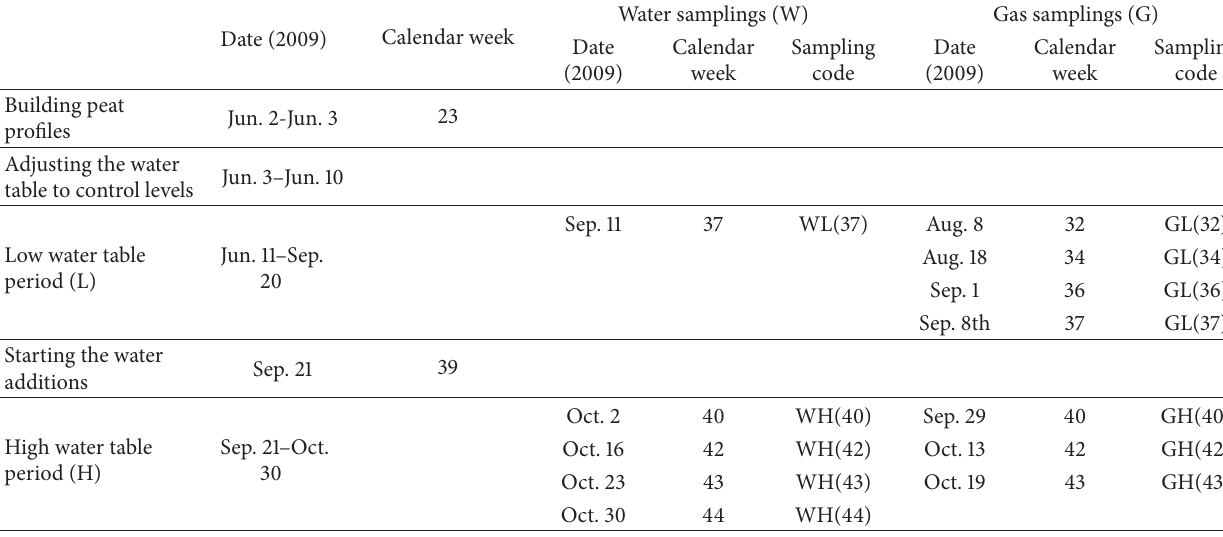
Table 1: Timetable of the experiment. Numbers in the sampling codes refer to calendar weeks.